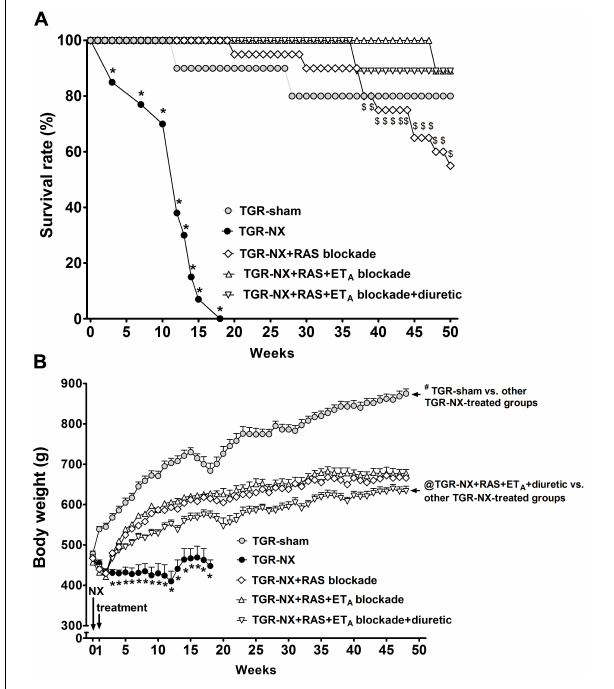
FIGURE 1 | The effect of diuretic treatment added to combined RAS and ET A blockade on survival and body weight. Survival rate (A) and body weight (B) in sham-operated TGR (TGR-sham), nephrectomized TGR (TGR-NX) untreated receiving water or treated with the renin-angiotensin system (RAS) blockade alone (TGR-NX + RAS blockade), combined RAS + ET A blockade (TGR-NX + RAS + ET A blockade) or diuretic given with the combined RAS + ETA blockade (TGR-NX + RAS + ET A blockade + diuretic). # P < 0.05 TGR-sham vs. other TGR-NX-treated groups, $ P < 0.05 TGR-NX + RAS treated vs. other TGR-NX-treated groups, @ P < 0.05 TGR-NX + RAS + ETA + diuretic vs. other TGR-NX-treated groups, ∗ P < 0.05 untreated TGR-NX group compared with all other treated TGR-NX groups at the same time